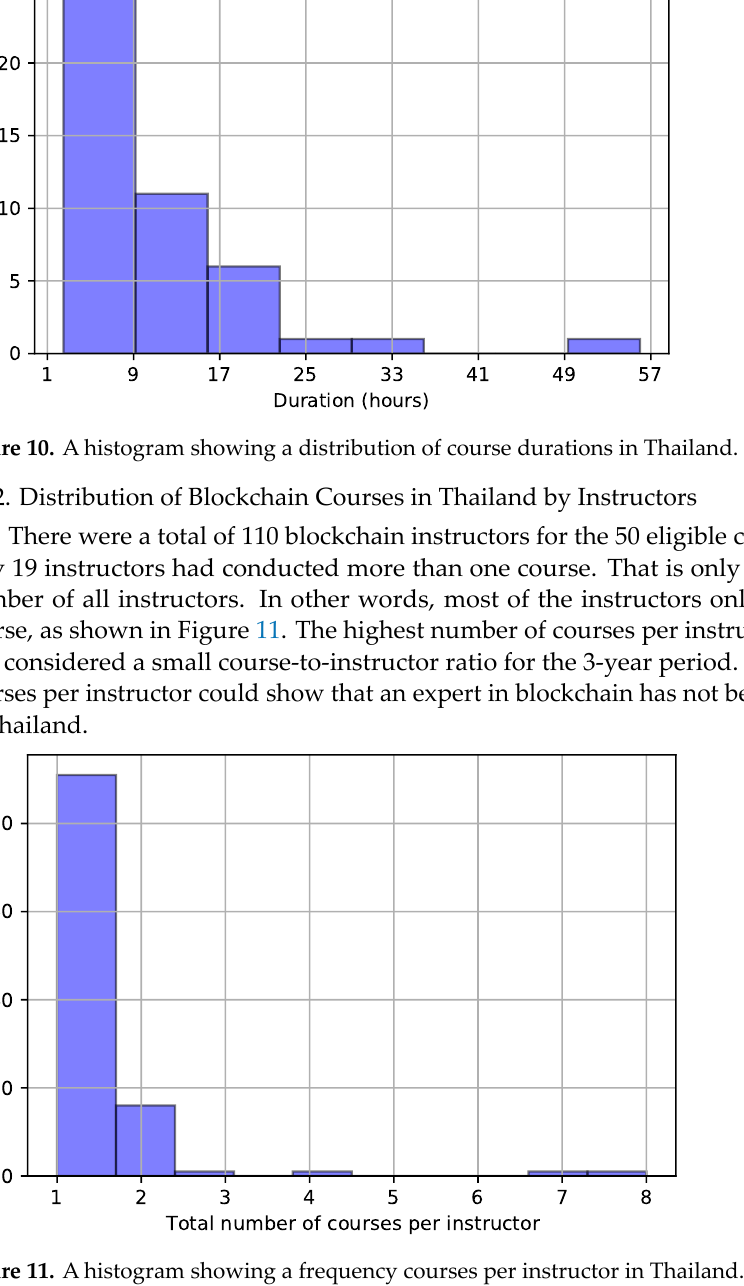
Figure 11. A histogram showing a frequency courses per instructor in